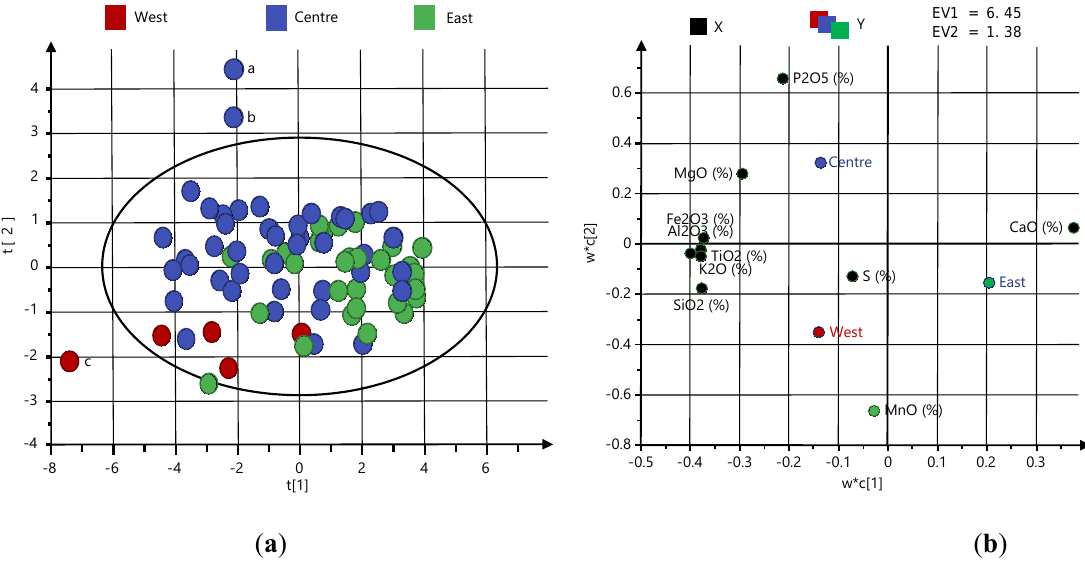
Figure 4. The PLS-DA score plot for the two first components colored according to classes ( a ) and the corresponding loading plot ( b ).